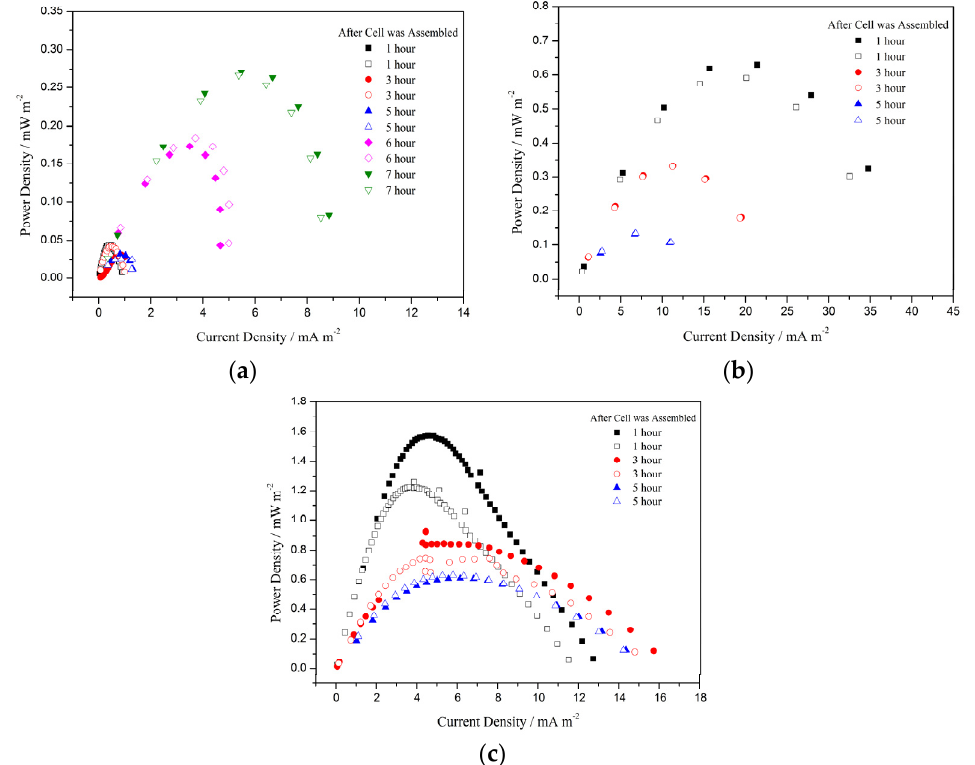
Figure 4. Current–power density curves of MFCs measured between 1 and 7 h after the cells were assembled; the electrodes were dried at temperatures of ( a ) 195, ( b ) 250, and ( c ) 325 °C .